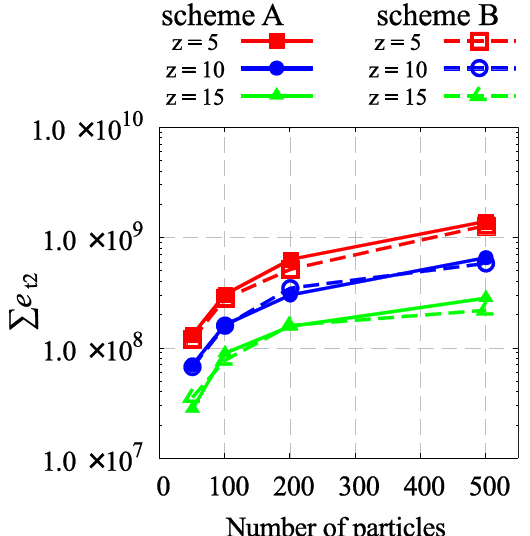
Figure 25. Kinetic energy of rebounding particles, where the energy is e t = 0.5 ρ p ( u p2 + v p2 ).